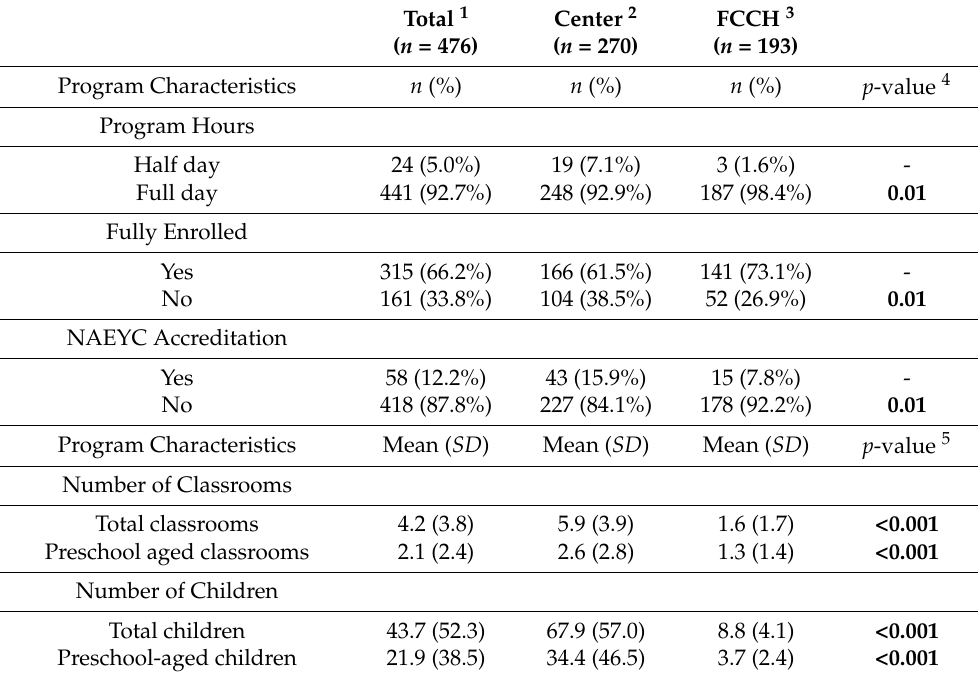
Table 1. Early care and education program characteristics ( n = 476), Oklahoma